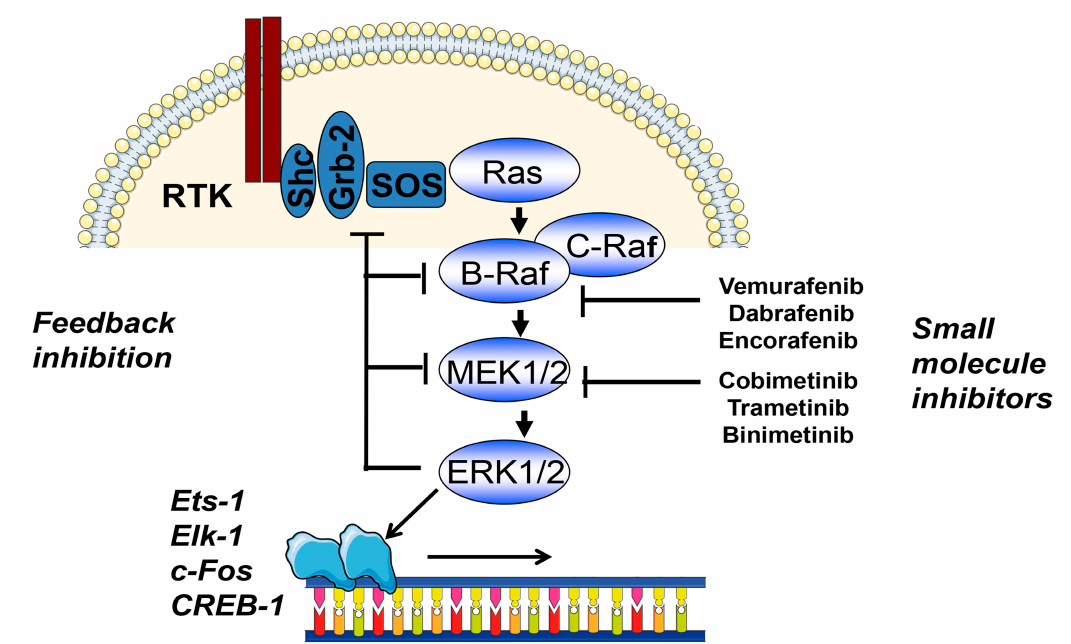
Figure 1. Schematic representation of the MAPK pathway in melanoma. Neuroblastoma RAS viral oncogene homolog ( NRAS ) and v-Raf murine sarcoma viral oncogene homolog B ( BRAF ) are the most commonly mutated oncogenes in melanoma and are strong activators of the MAPK pathway. Within this pathway negative feedback occurs towards mitogen-activated protein kinase kinase 1/2 (MEK1/2), BRAF and son of sevenless homolog (SOS). BRAF and MEK1/2 may by targeted by specific small molecule inhibitors. The activated MAPK pathway further activates transcription factors such as Ets-1, Elk-1, c-Fos, and CREB-1. Abbreviations: RTK, receptor tyrosine kinase; Shc, Src homology 2 domain containing adaptor protein; Grb-2, growth factor receptor bound protein 2; SOS, son of sevenless homolog. Ets-1, V-Ets avian erythroblastosis virus E26 oncogene; Elk-1, ETS-like gene 1; c-Fos, Fos proto-oncogene, AP-1 transcription factor subunit; CREB-1, CAMP responsive element binding protein 1.